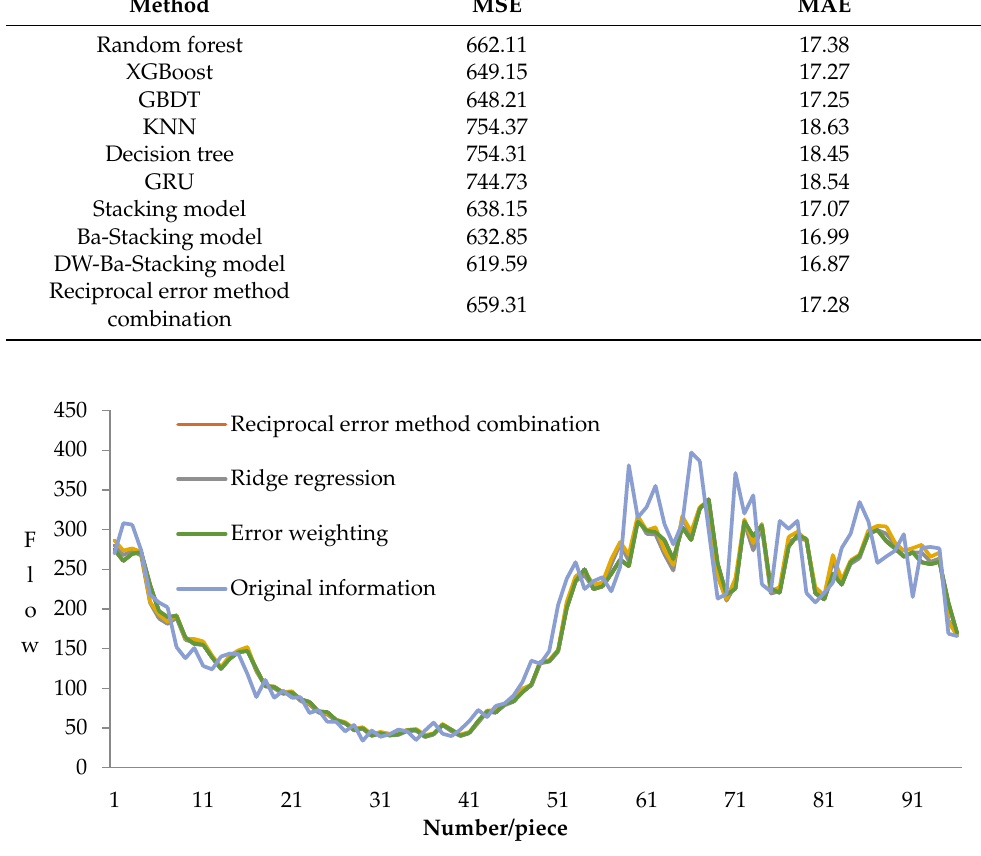
Table 5. The Ba-stacking model prediction effect of different meta-learners.